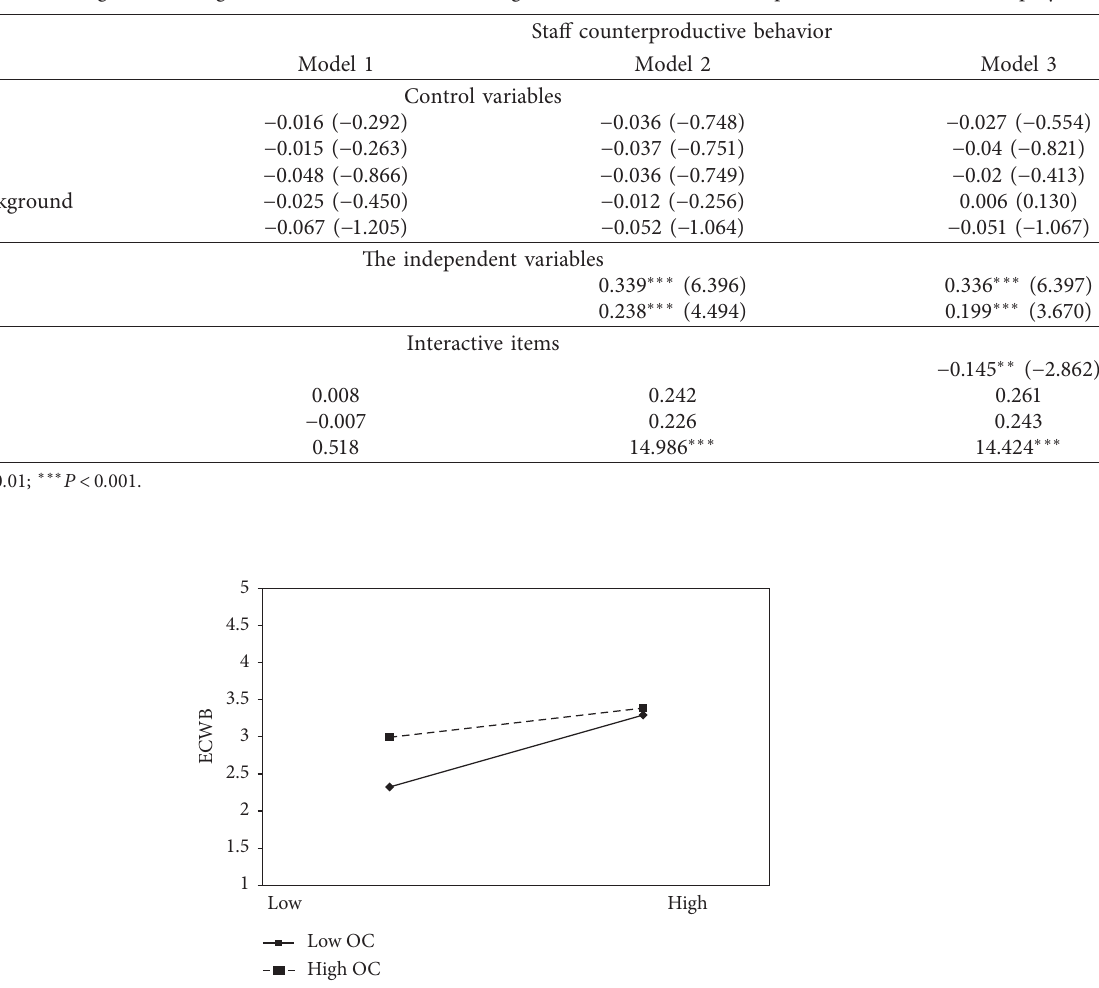
Table 9: The moderating effect of organizational commitment on negative emotions and counterproductive behavior of employees.